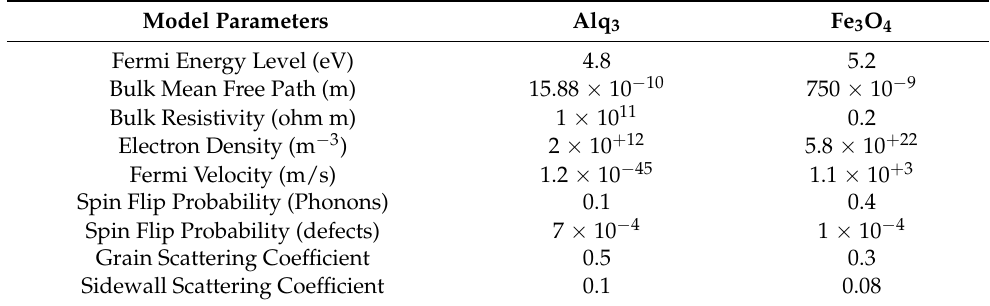
Table 1. Spin Transport dependent Model Parameters for Organic Semiconductor Alq 3 and magnetic electrode Fe 3 O 4